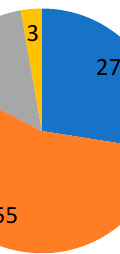
Figure 2. Discovery of antibiotics adapted from [25].